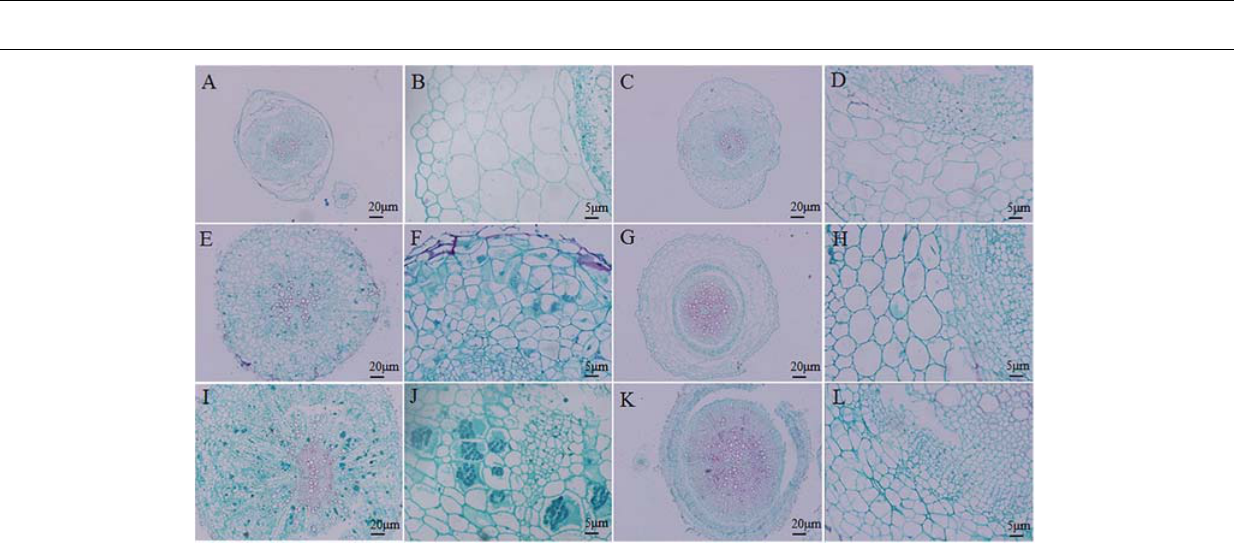
Frontiers in Plant Science |